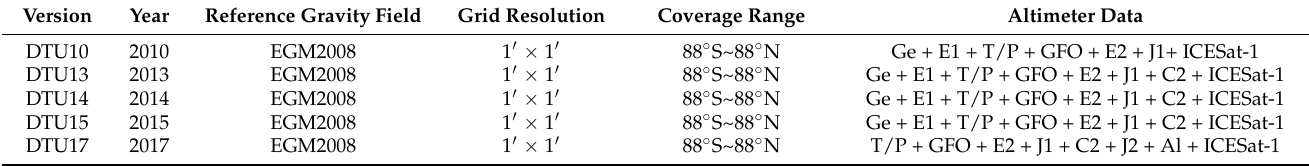
Table A3. KMS-DNSC-DTU series global marine gravity anomaly